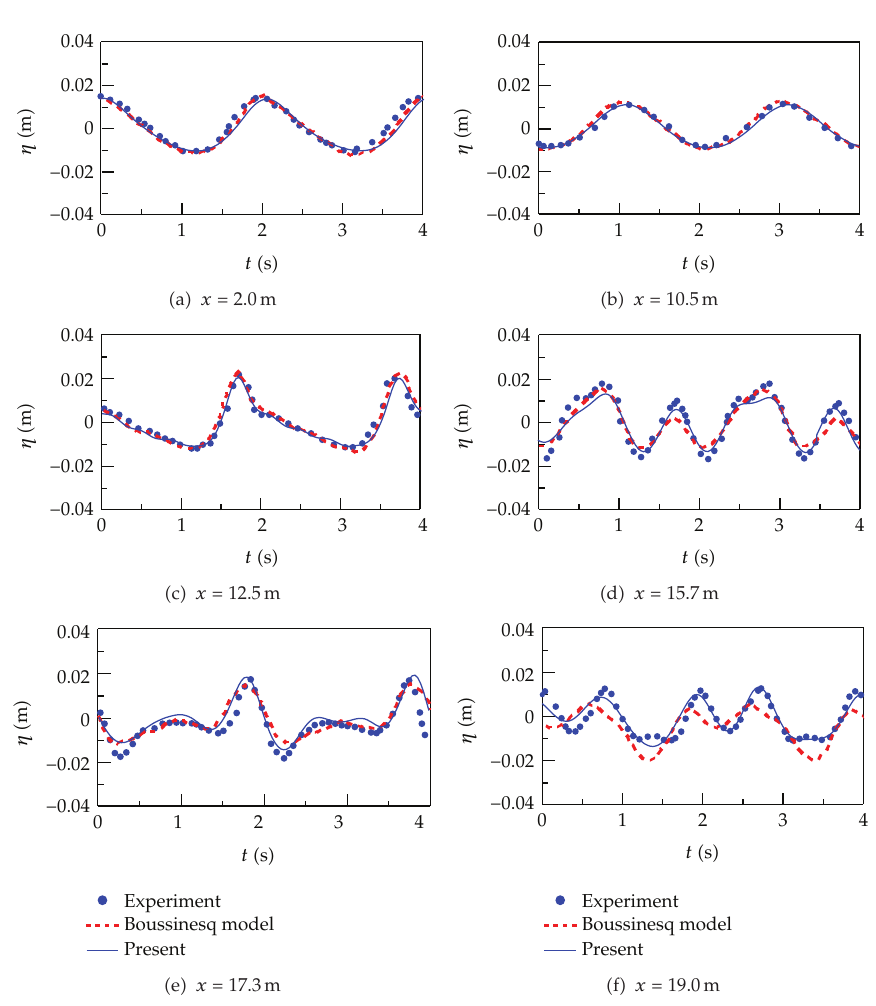
Figure 4: Comparisons of free surface displacement among the experiment, Boussinesq model, and present